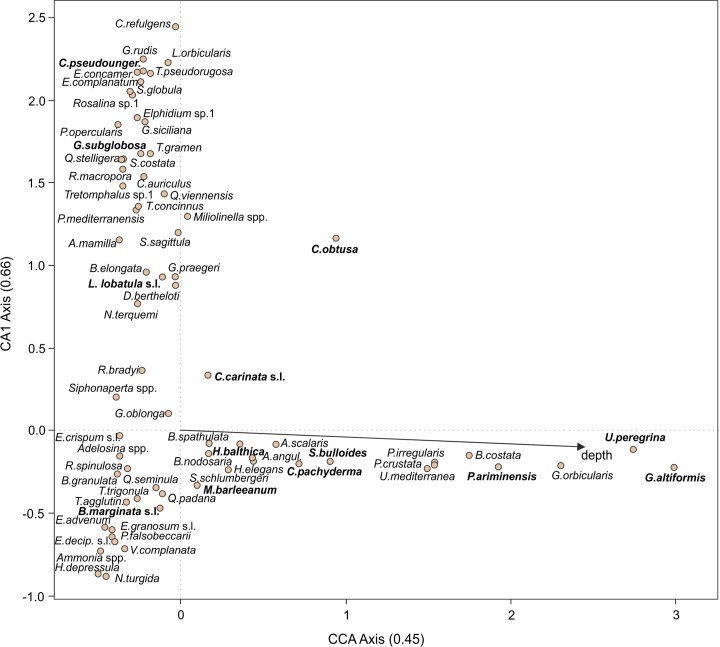
Canonical correspondence analysis (CCA) of the combined modern data set.In bold the species that are dominant in the fossil data set are marked while the eigenvalues of the constrained (CCA) and unconstrained (CA1) axes are given in parentheses.